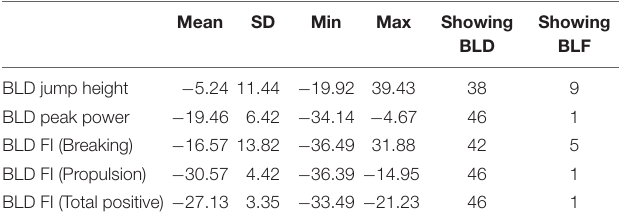
TABLE 2 | Descriptive statistics for BLD outcomes.